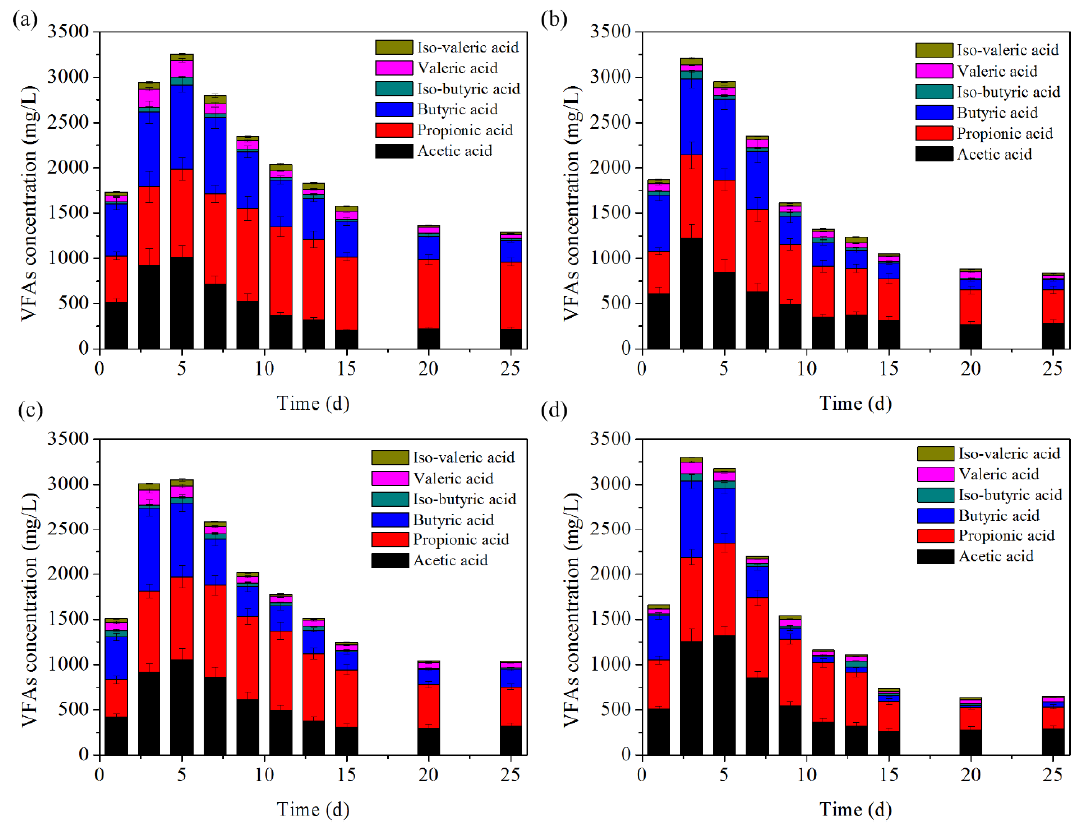
Figure 2. Changes of volatile fatty acids (VFAs) components in ( a ) R1 (Control test), ( b ) R2 (with Ni 2+ addition), ( c ) R3 (with EDTA addition), ( d ) R4 (with EDTA-Ni addition).